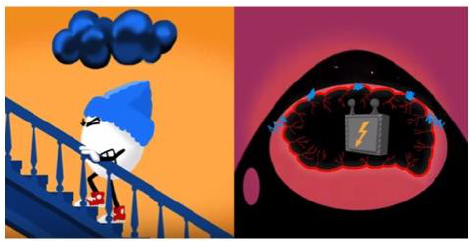
Figure 8 . Image obtained from the online video, ‘Migraine: how it works and how to get it under control’